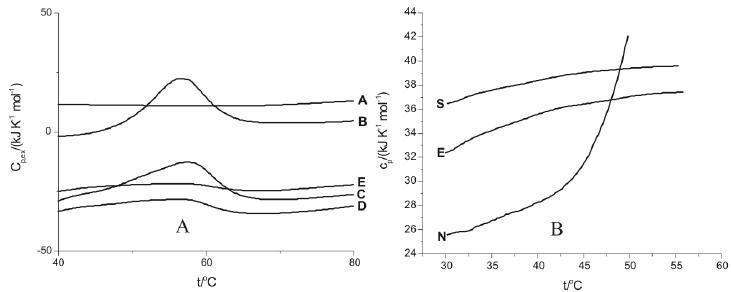
Figure 10. DSC scans of 10 mg ml 2 1 lysozyme (A) at the different stages of fibrillization process: line A represents only buffer, B represents for naı¨ve lysozyme, line C represents for nucleation phase after 48 h of incubation, line D represents for elongation period after 61 h of incubation and line E represents for saturation phase after 90 h of incubation and (B) showing change in heat capacity at the different stages of fibrillization process: line N represents C p for native stage, line E represents C p for elongated stage and line S represents C p for saturation stage.